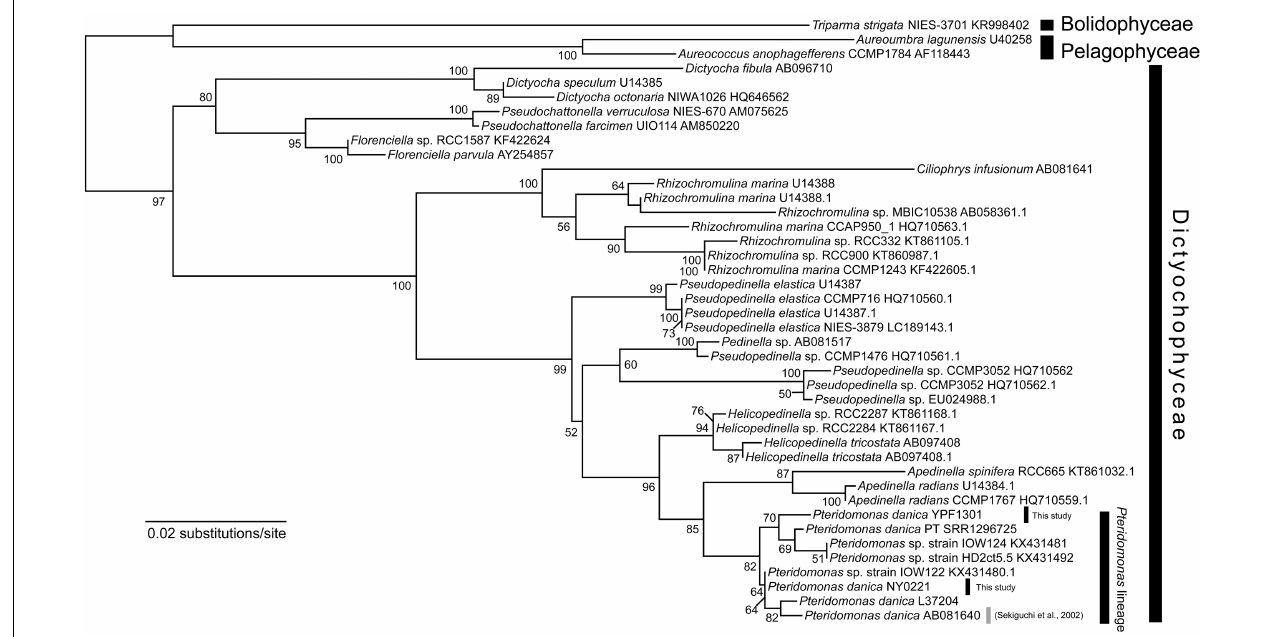
FIGURE 1 | Maximum likelihood tree of 18S rRNA gene sequences of Dictyochophyceae. The tree was inferred with IQ-TREE 1.6.12 under the GTR + (cid:48) + I model. Bootstrap values ≥ 50 are shown on branches. P. danica reported to bear rbcL is highlighted by gray line (Sekiguchi et al., 2002).